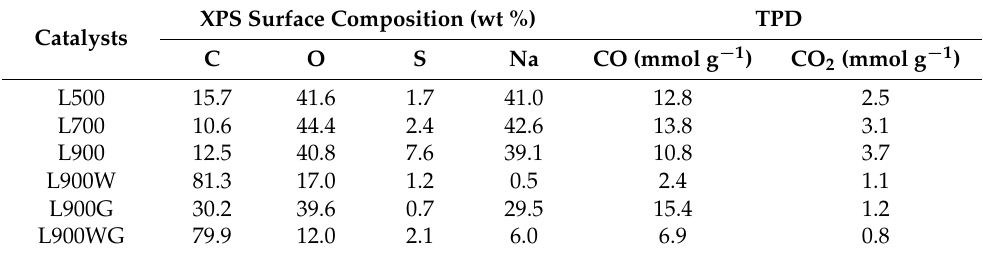
Table 3. Mass surface concentration determined by X-ray photoelectron spectroscopy (XPS) analyses and amounts of CO and CO 2 evolved with temperature during the temperature-programmed desorption (TPD) experiment for the different carbon catalysts.